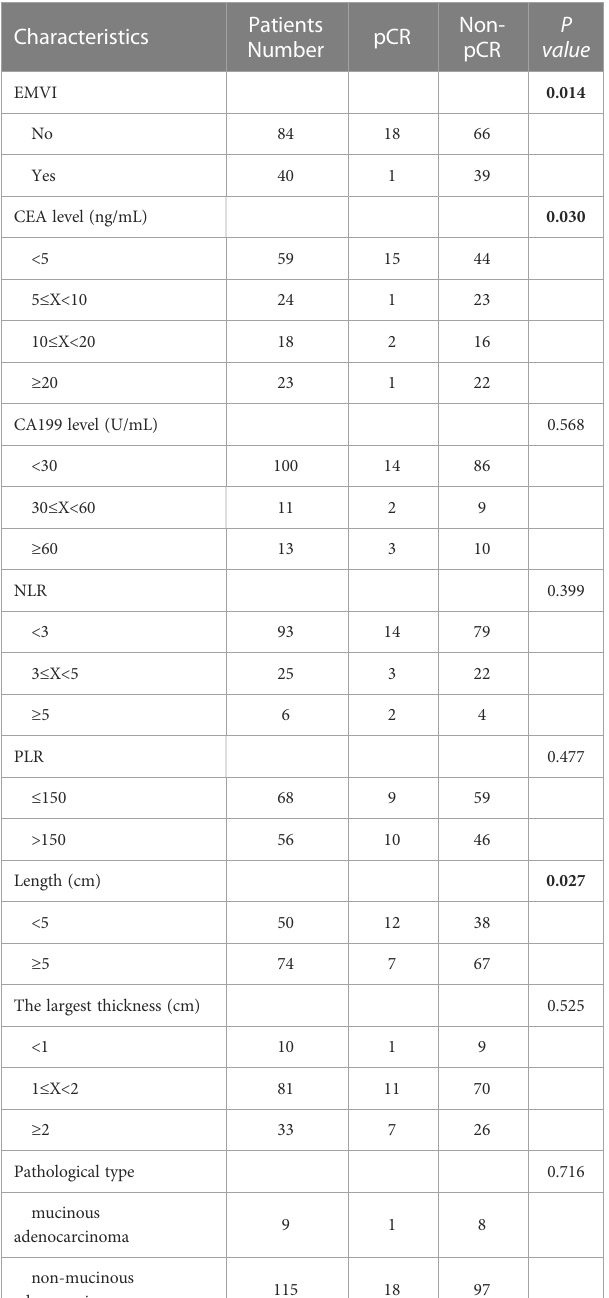
TABLE 1 Characteristics of patients with or without